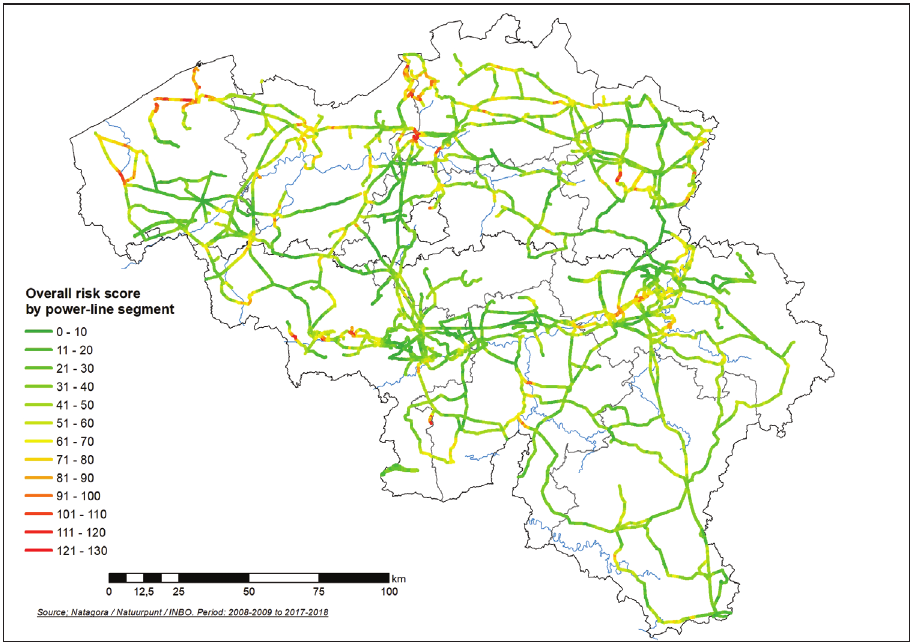
Figure 2. Map of the existing transmissions lines, colour-coded according to the bird collision risk they represent. Most of the high-priority lines are close to important waterbird sites, but numerous segments are also located in the central part of the country, in the historically industrial river valleys.